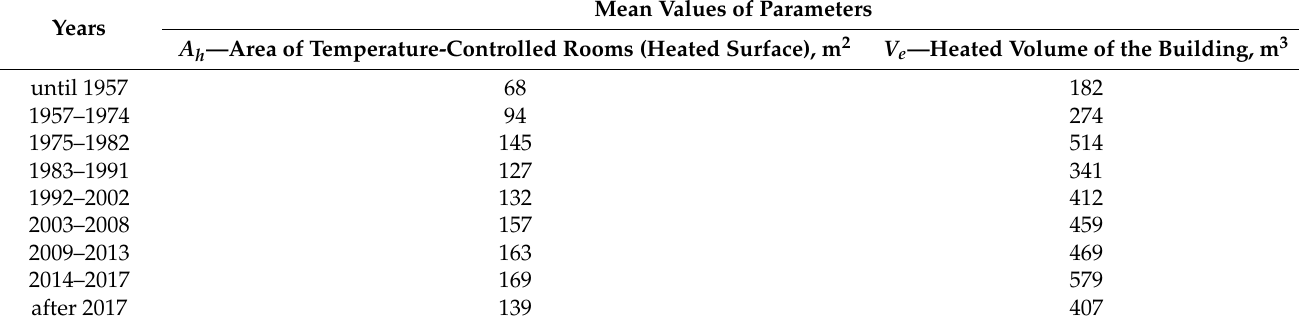
Table 2. Average values of surface area and heated cubic capacity for the analyzed group of buildings. Mean Values of